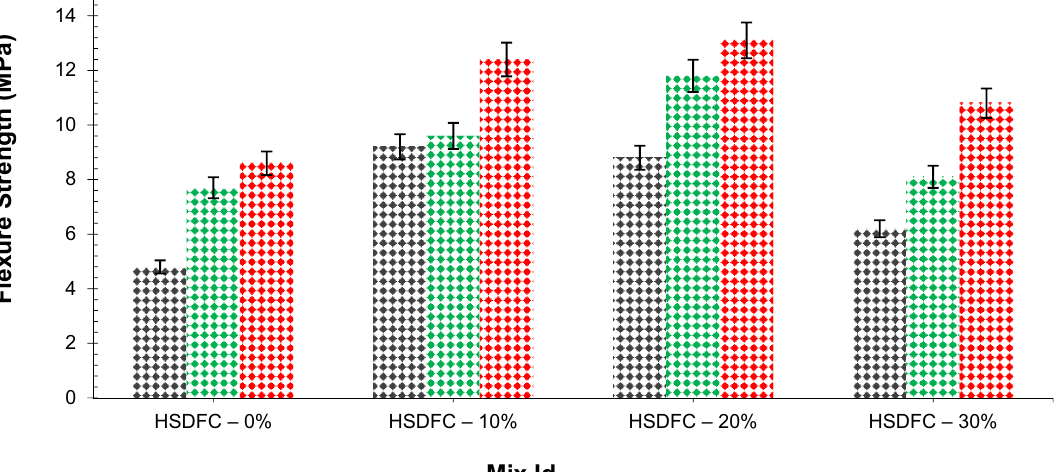
Figure 8. Flexure strength.